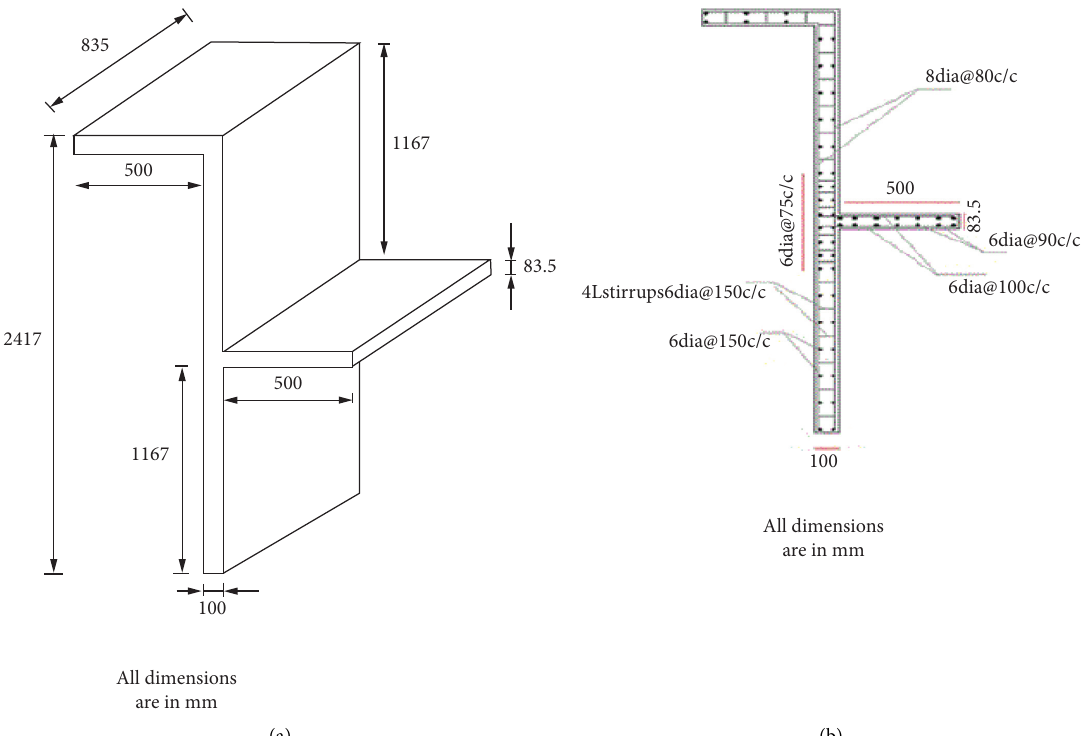
Figure 1: Geometry and detailing of RC shear wall-slab connection from previously conducted experimental work that is used for FE validation